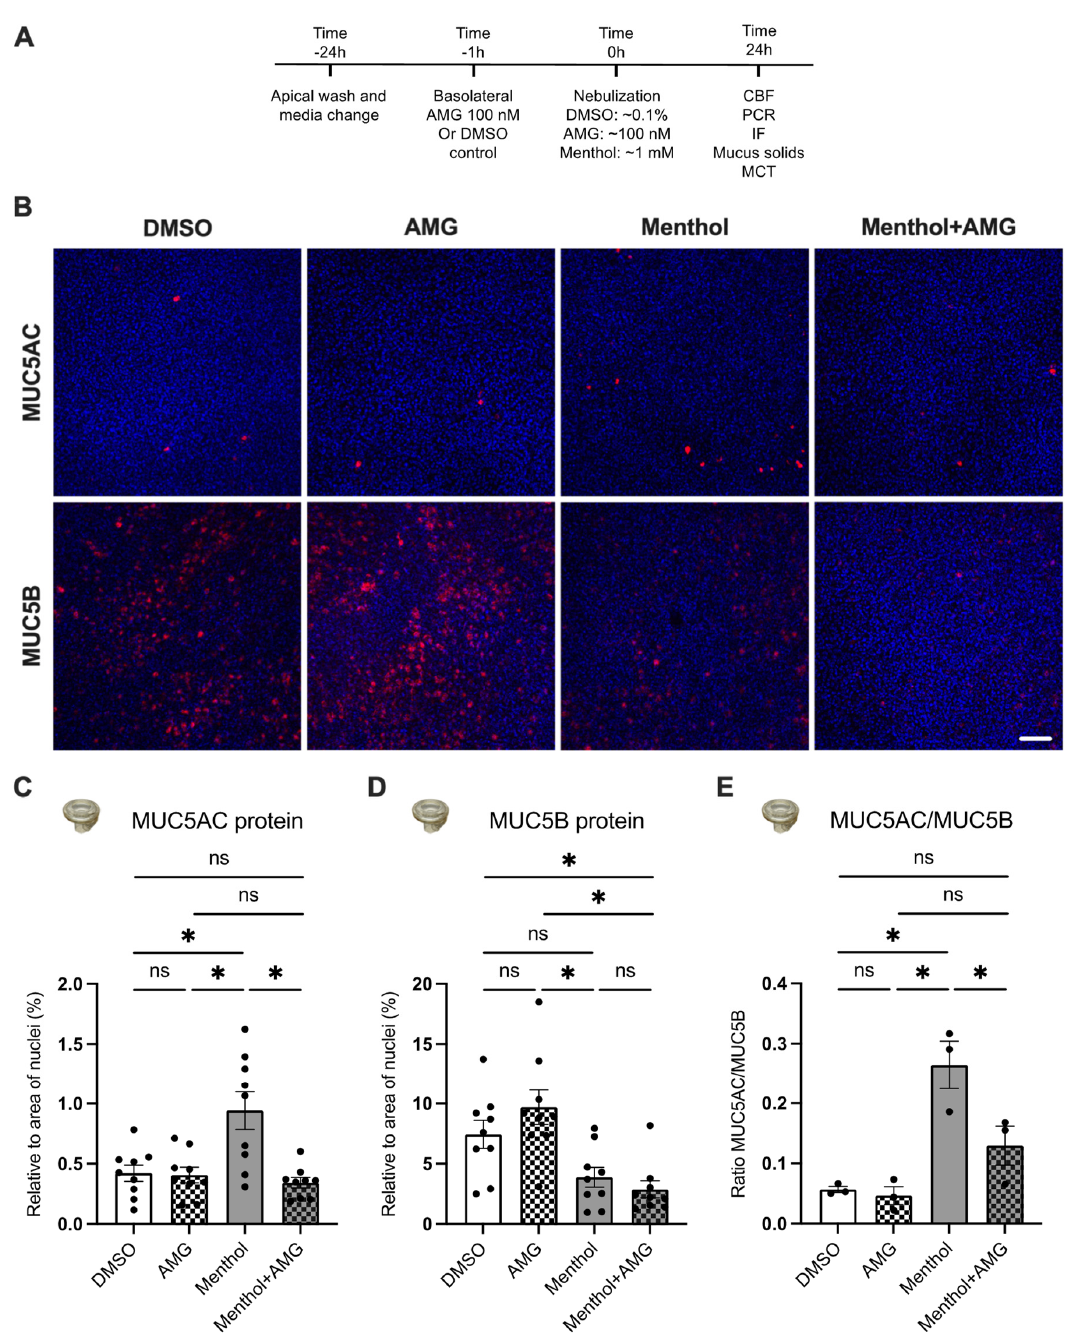
Figure 4. Effects of nebulized menthol and a TRPM8 antagonist on mucin expression in primary HBEC. ( A ) Schema of experimental design. All measurements were recorded 24 h after nebulization of DMSO (~0.1% final in the ASL, control) and menthol (~1 mM) with or without the TRPM8 antagonist AMG333 (~100 nM final in the ASL and 100 nM in the basolateral media). ( B ) Representative confocal images of MUC5AC and MUC5B (in red) as well as nuclei (Hoechst in blue). Scale bar represents 50 µm. ( C , D ) Quantification of expression of MUC5AC and MUC5B expressed as a ratio of surface area labeling of MUC5AC/Hoechst ( C ) and MUC5B/Hoechst ( D ), respectively. n = 9, 3 lungs. ( E ) Ratio of MUC5AC to MUC5B protein expression. n = 3 lungs. Statistics: Data shown as mean ± SEM. * p < 0.05, two–way ANOVA followed by Holm–Sidak ( B , C ) or one–way ANOVA followed by Holm–Sidak ( D ) after assessing normality with Shapiro–Wilk.